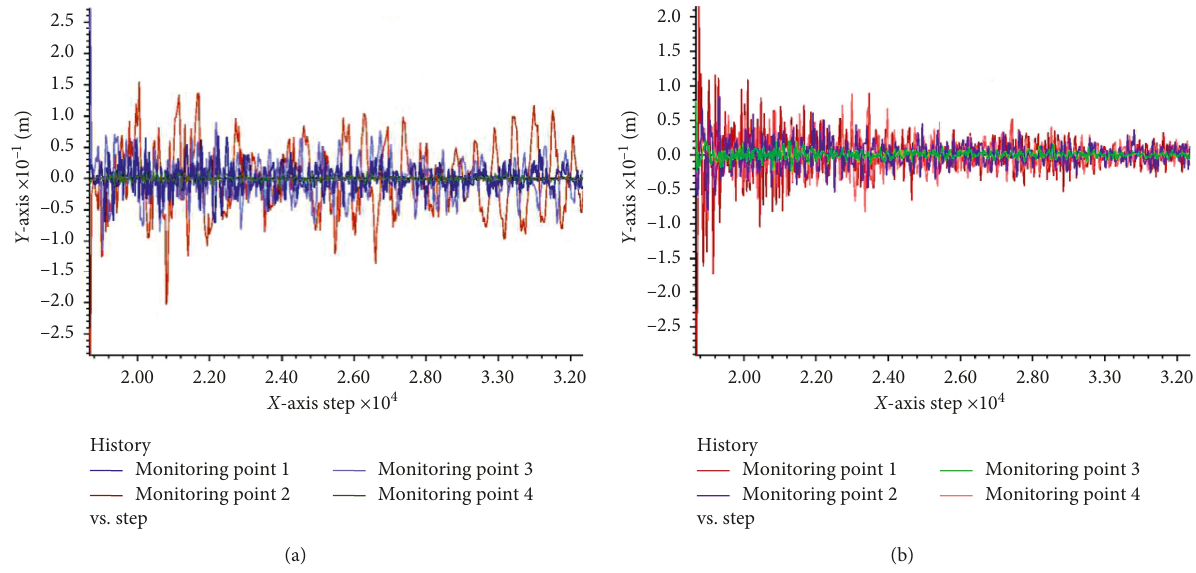
Figure 15: Velocity response diagram for one dynamic load. (a) X -directional deformation velocity and (b) Z -directional deformation velocity.